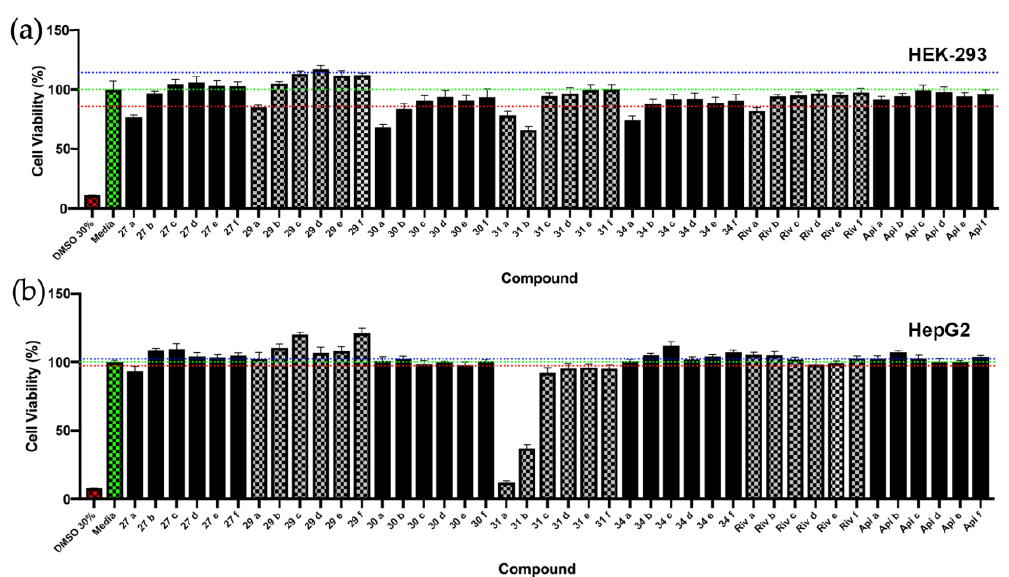
Figure 8. Effect of selected compounds on cell viability using the MTS assay in ( a ) HEK293 and ( b ) HepG2 cell lines. Concentrations used were 100 mM (a), 10 mM (b), 100 nM (c), 50 nM (d), 10 nM (e), and 1 nM (f). Blue and red lines defines ± 2 SD limits from the average value of control wells treated only with vehicle (green line). All values are means ± S.D ( n = 6) vs. control. Api: Apixaban and Riv: Rivaroxaban. SD: standard deviation